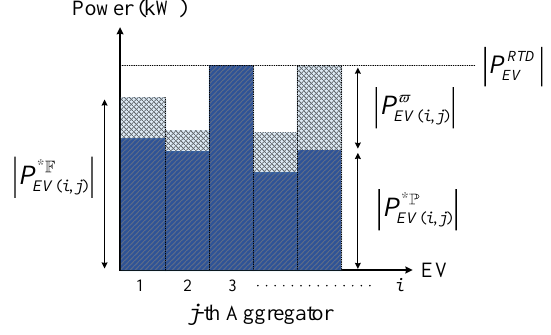
Figure 6. Final EV power allocation using water-filling